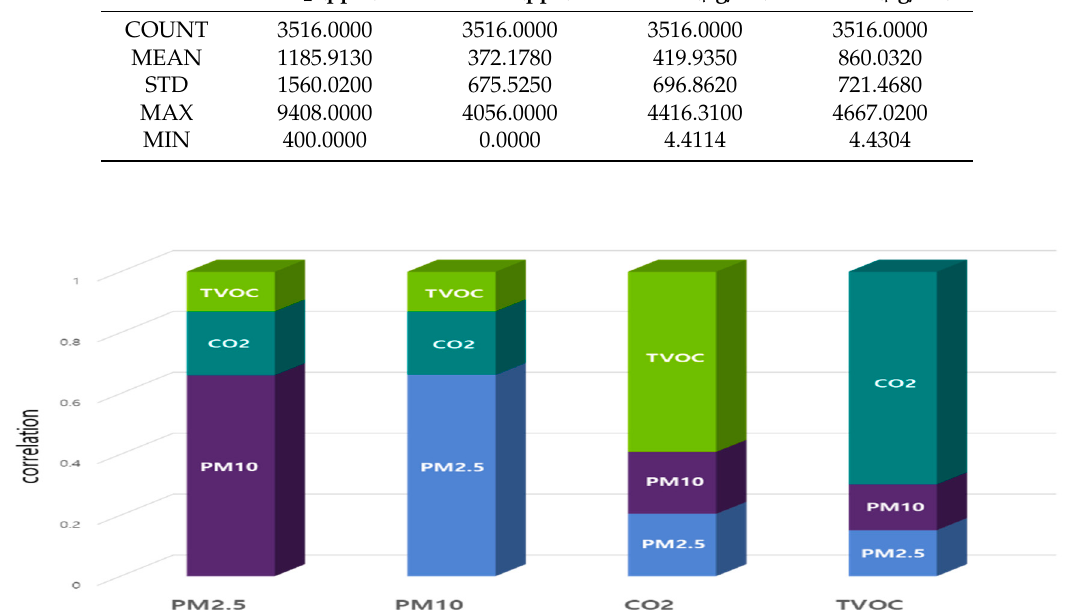
Figure 8. Correlation results of graph in all situations .